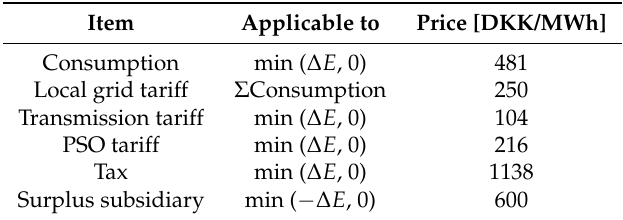
Table 1. Current pricing scheme for residential PV systems in Denmark [28,29].